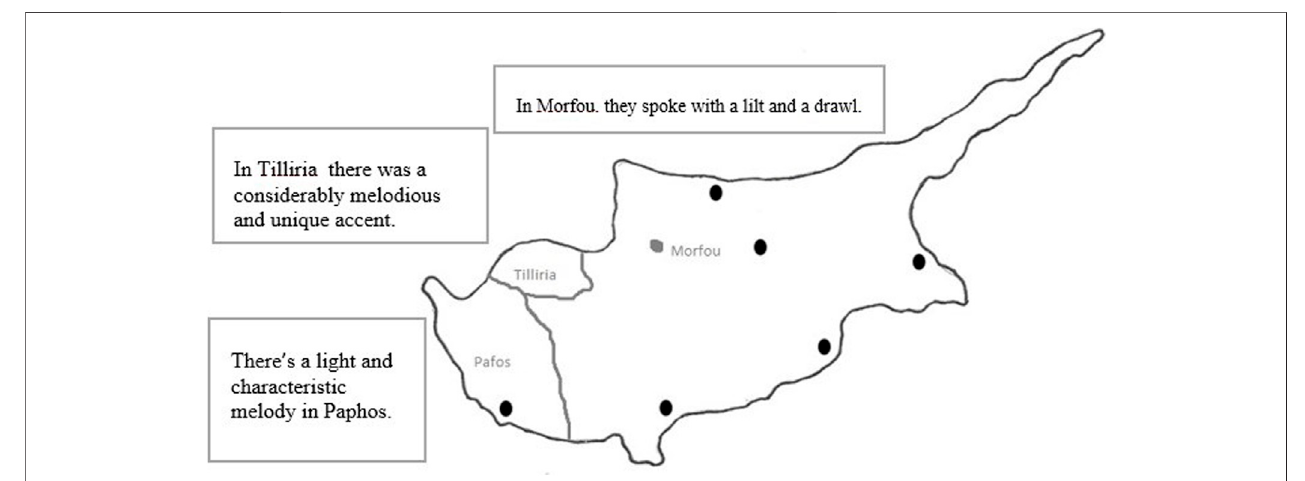
FIGURE 7 | Map drawn by participant